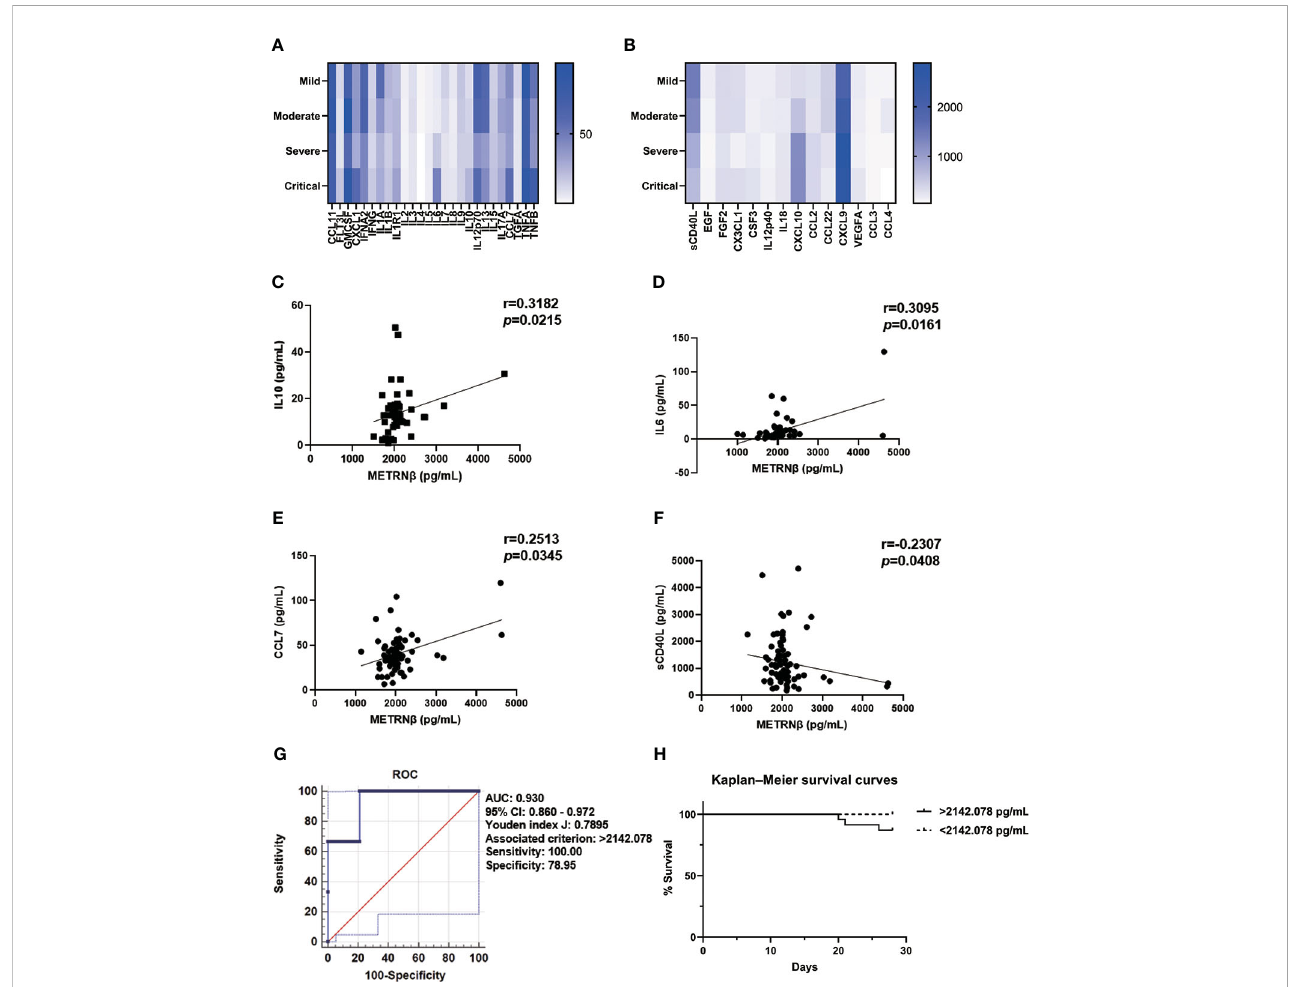
FIGURE 2 METRN b served as a surrogate prognostic biomarker in COVID-19 patients in the prediction cohort. (A, B) Longitudinal cytokine/chemokine pro fi le of COVID-19 patients (n = 54 – 98) with the human Cytokine Milliplex MAP assay kit. The results are shown as heat maps. (C – F) Correlation analysis of serum METRN b concentration with IL10 (n = 52), IL6 (n = 60), CCL7 (n = 71), and sCD40L (n = 79). Spearman ’ s correlation coef fi cient was used for the analysis. (G) ROC of serum METRN b levels on admission to distinguishing survivors from non-survivors of COVID-19 patients. The AUC was 0.930 (95% CI: 0.860 – 0.972) for serum METRN b levels on admission in the prediction cohort of COVID-19 patients with non-Omicron-SARS-CoV-2 infection (n = 98). (H) Kaplan – Meier survival curves of COVID-19 patients with non-Omicron-SARS-CoV-2 infections in the prediction cohort based on the METRN b cut-off value (2142.078 pg/mL) on the day of admission. AUC, area under the